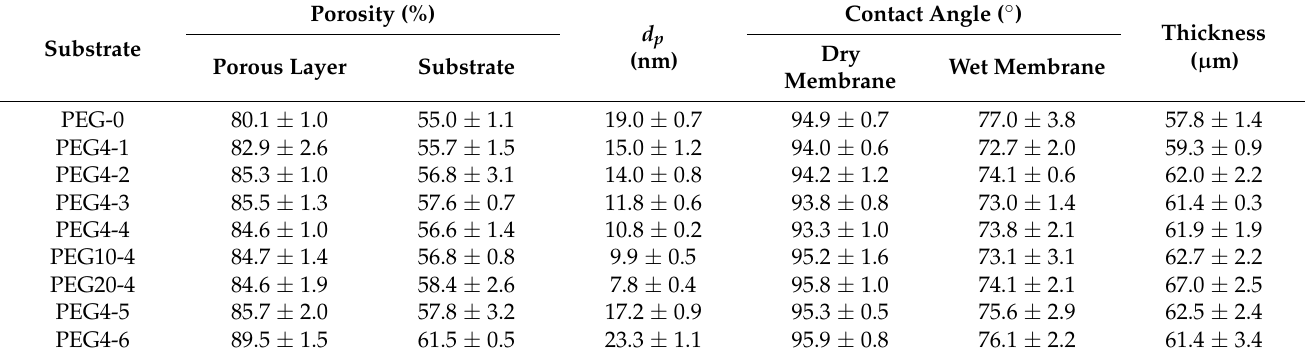
Table 2. Porosity, mean pore size, contact angle and thickness of PSU/PEG